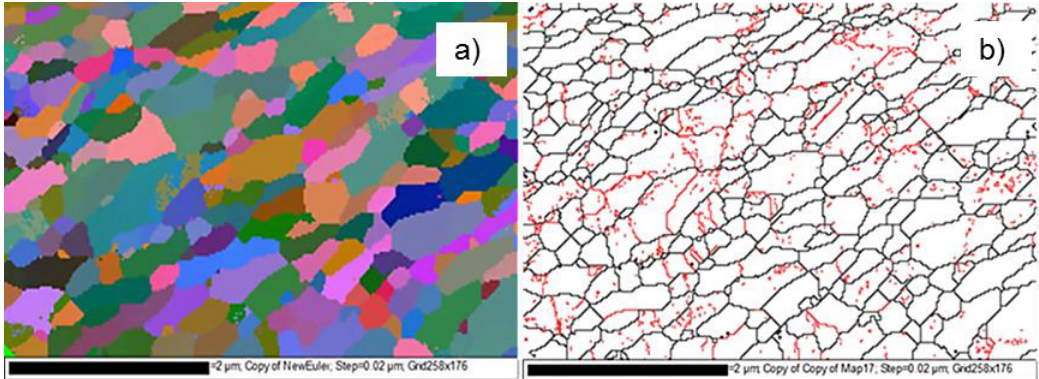
Figure 10. Fully ultra-fine grained CuNi3Si1Mg Electron Backscatter Diffraction Pattern (EBSD) orientation mapping showing Euler-orientations ( a ) and grain boundaries ( b ). High-angle grain boundaries are depicted in black, Low-angle grain boundaries are depicted in red).